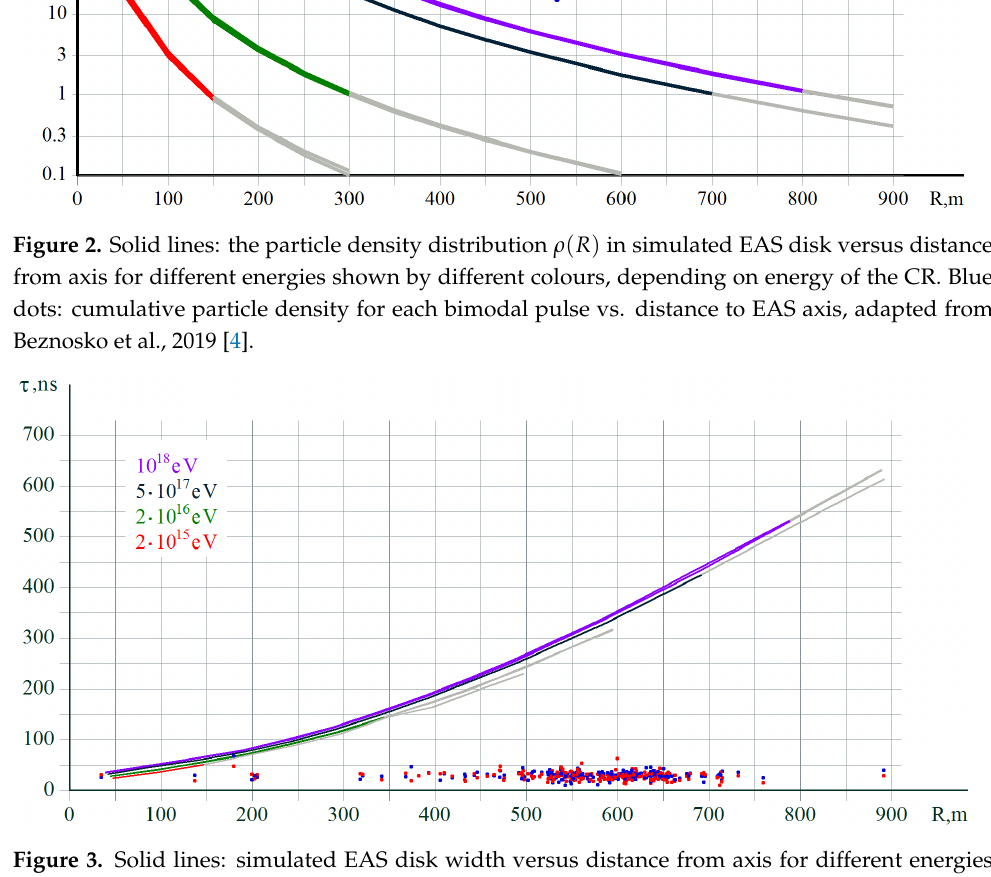
Figure 3. Solid lines: simulated EAS disk width versus distance from axis for different energies shown by different colours. Pulse width τ 0.8 in ns for the first pulse (in blue) and second pulse (in red) for the bimodal pulses versus distance to the EAS axis, adapted from Beznosko et al., 2019